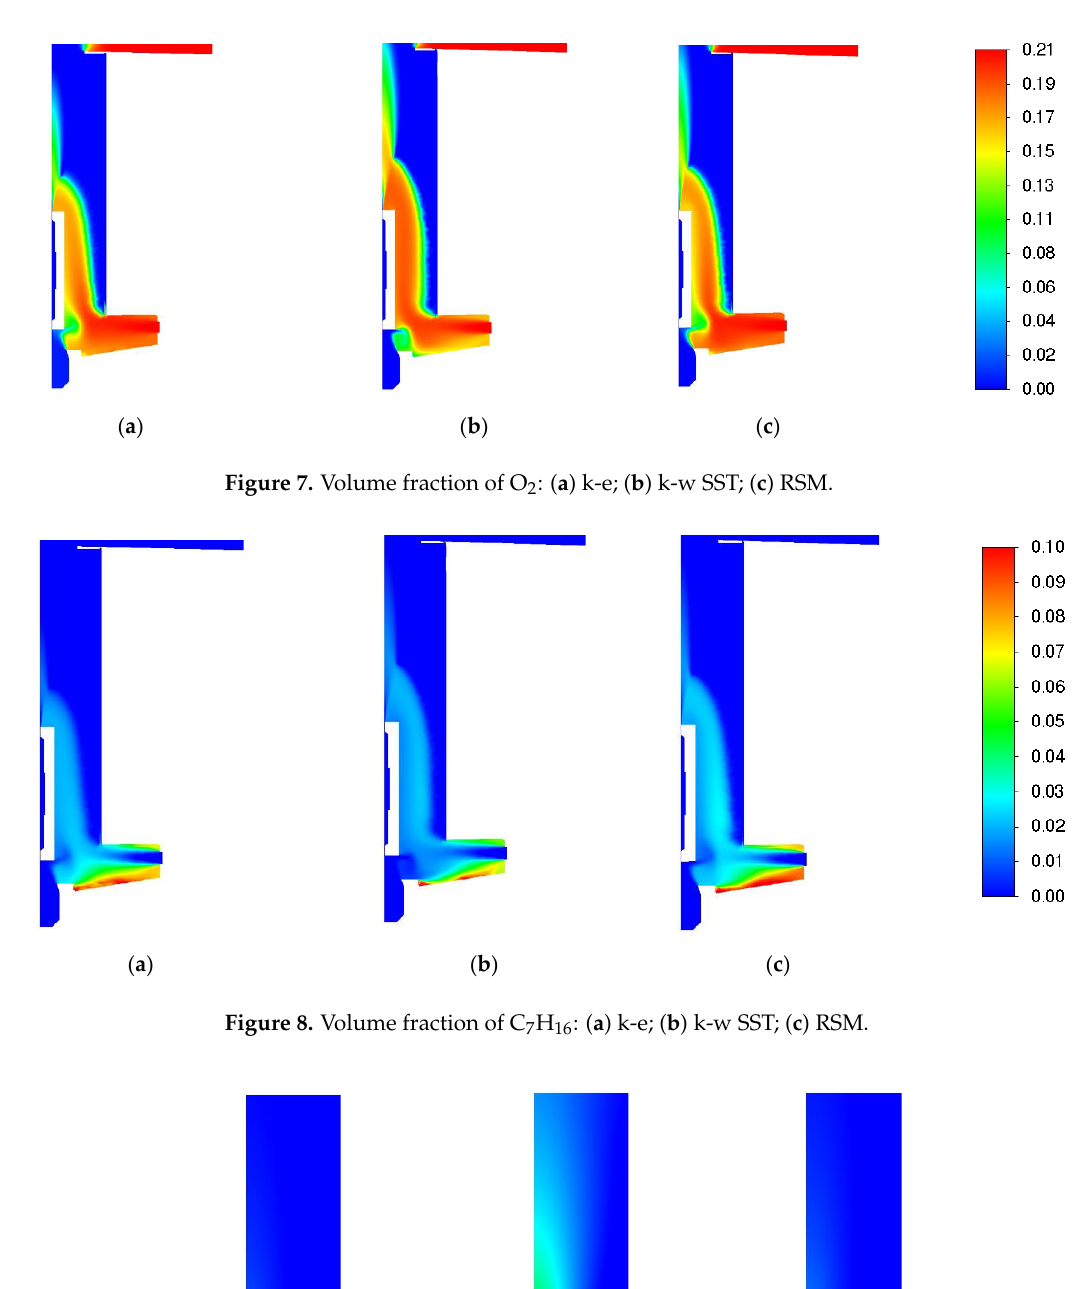
Figure 6. Temperature in the burnet and at its outlet, °C: ( a ) k-e; ( b ) k-w SST; ( c ) RSM.